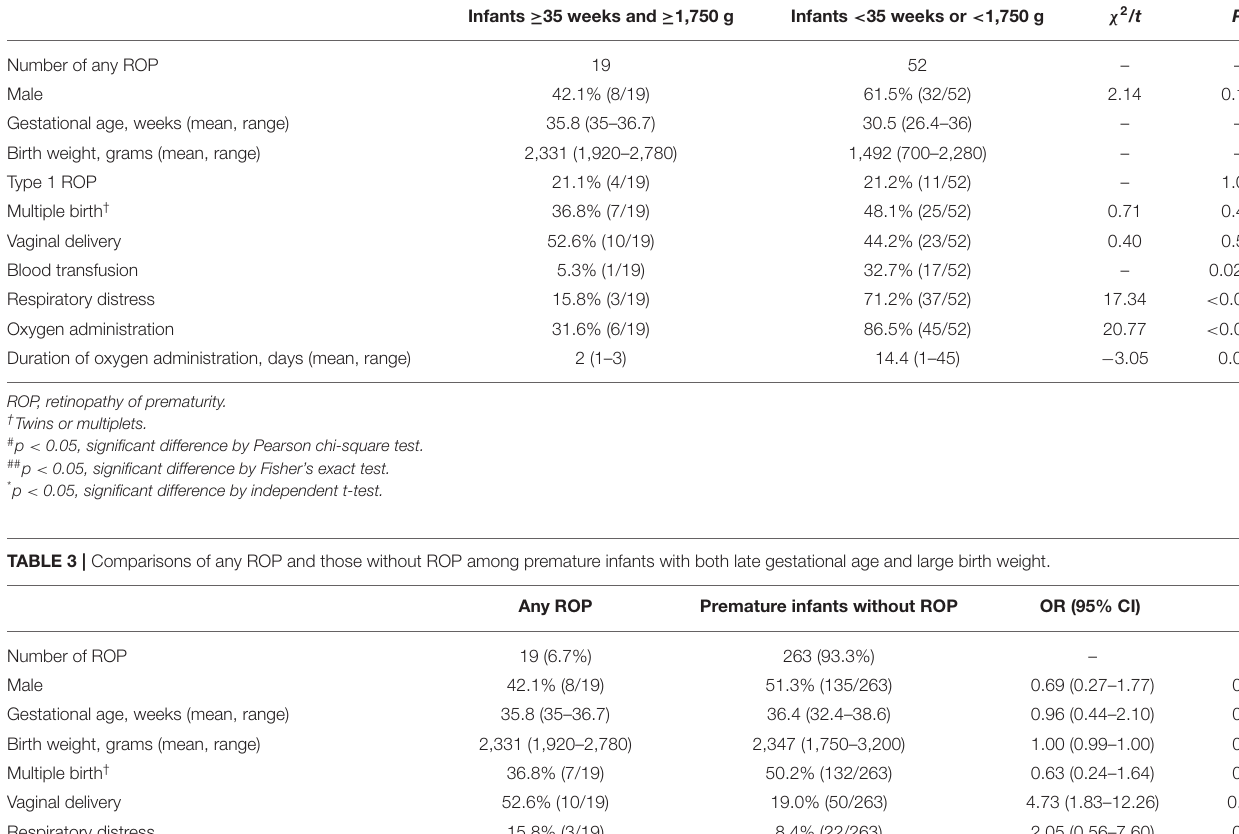
TABLE 2 | Characteristics of any ROP with both late gestational age and large birth weight.